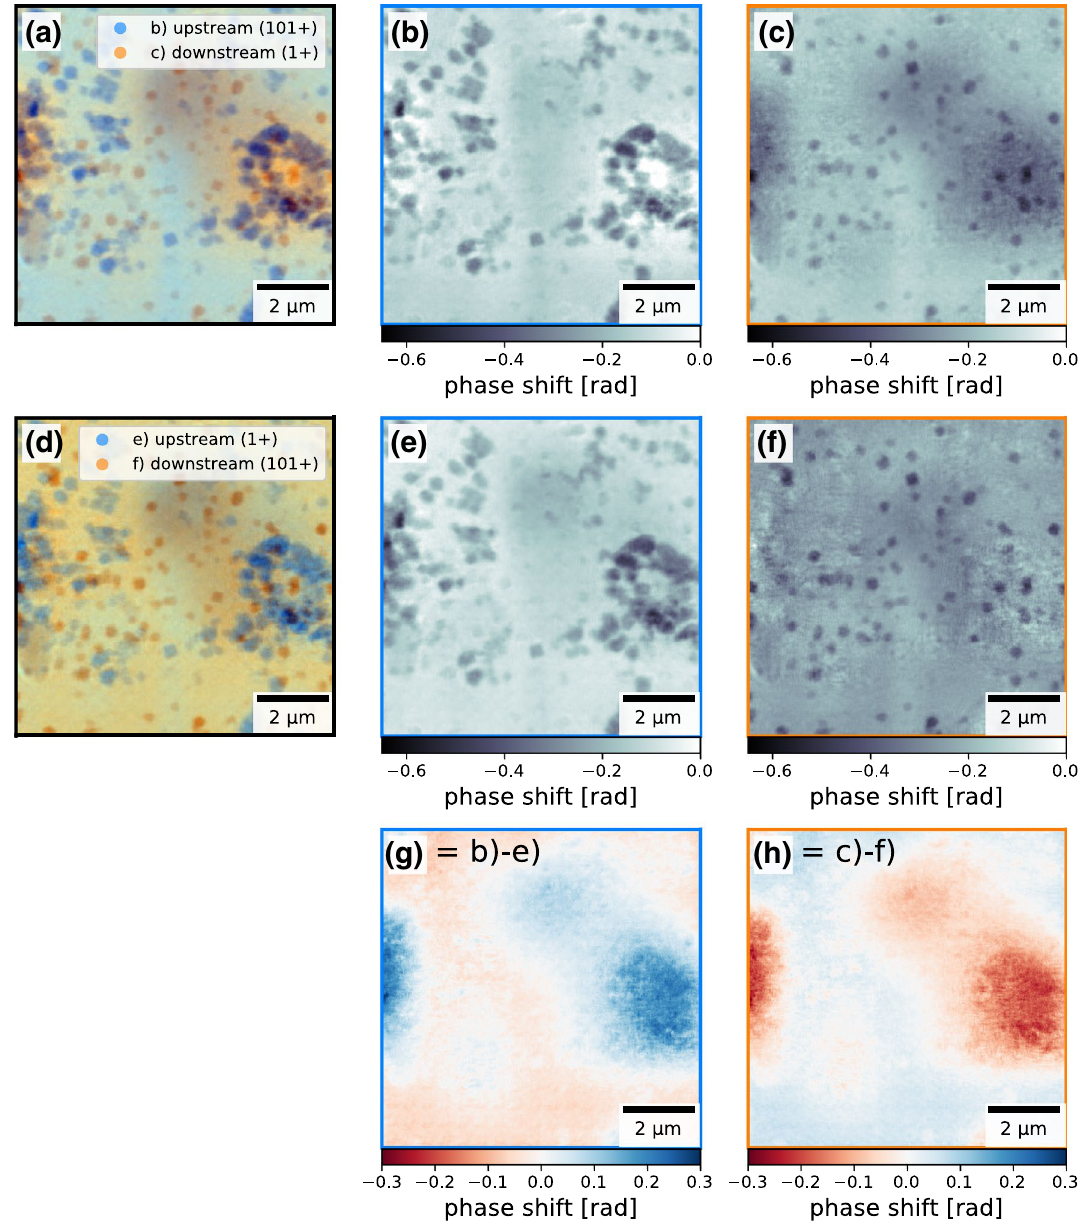
Figure 5. Comparison of two multi-slice reconstructions of the same recorded dataset from the single polyimide foil experiment with inverted initialization order of the two object slices: ( a )–( c ) reconstructed object slices where the downstream sample slice was initialized first, ( d )–( f ) reconstructed object slices where the upstream sample slice was initialized first, ( g ) and ( h ) difference between the reconstructed up-/downstream slices respectively between the two initialization cases showing the long range cloud like artefacts switching slices depending on the initialization order. The figure was created using matplotlib 35 (version 3.1.3 36